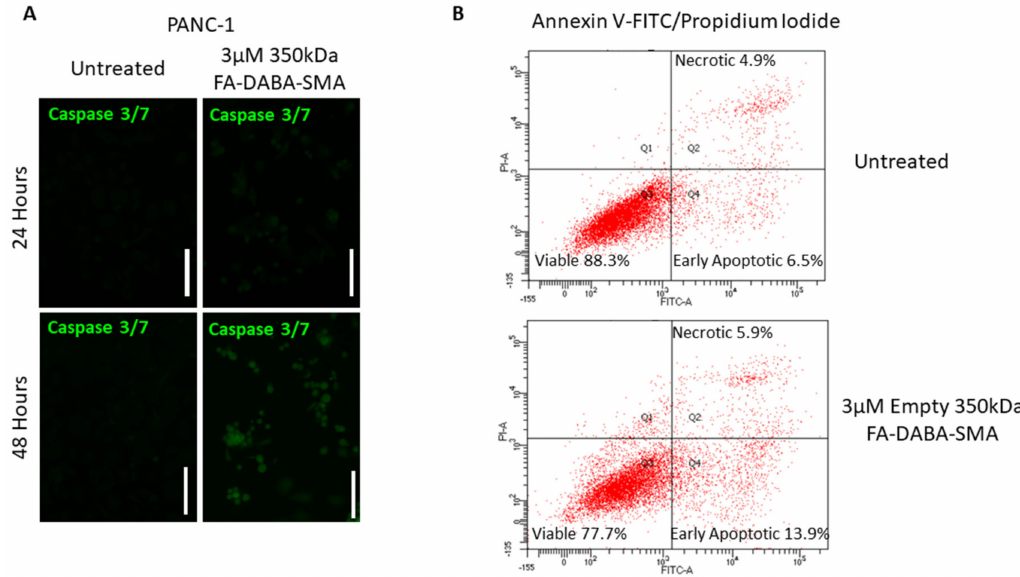
Figure 7. Caspase 3 / 7 and Annexin-V apoptotic activity post-treatment with 350 kDa FA-DABA-SMA on PANC-1 pancreatic cancer cells. ( A ) Immunocytochemistry staining for caspase on the PANC-1 cell line before after 24 and 48 hours of 3 µ M FA-DABA-SMA (350 kDa) treatment. The white scale bar represents 100 µ m, and pictures were taken at 400 × magnification. Blue DAPI stain represents the nuclei, and green staining is caspase expression. ( B ) Flow cytometry of the Annexin-V apoptosis assay of untreated PANC-1 cells or 48 hours after treatment with 3 µ M FA-DABA-SMA (350 kDa). An estimate of ~250,000 cells was collected and stained with Annexin V-FITC / propidium iodide to assess the stage of apoptosis.